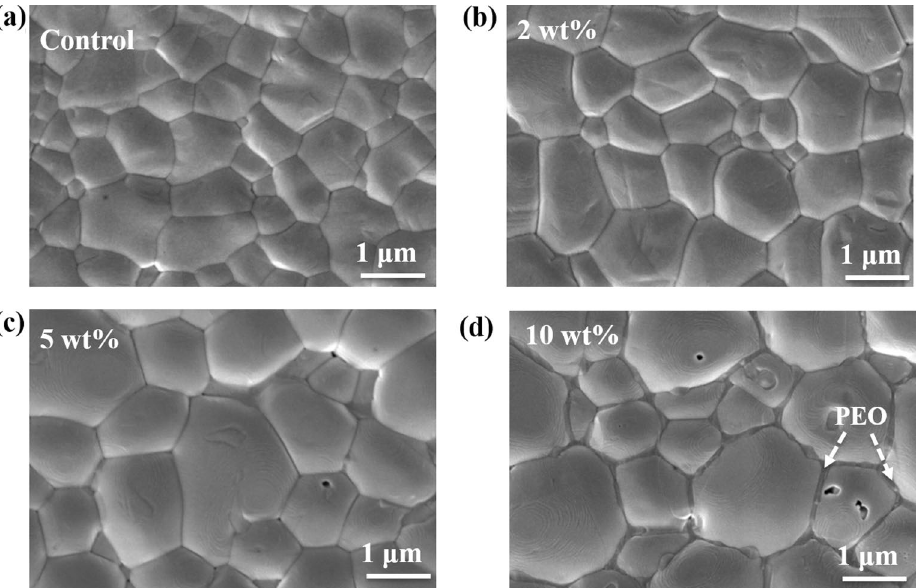
Figure 1. SEM top surface images of perovskite films deposited on FTO substrate with ( a ) 0, ( b ) 2, ( c ) 5 and ( d ) 10 wt% of